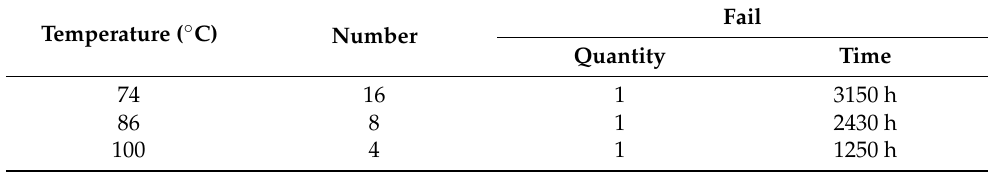
Table 5. Failure results after accelerated life